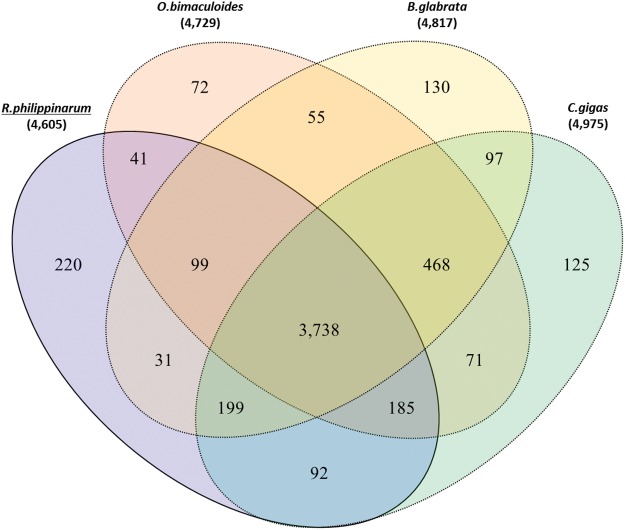
Orthologous gene clusters in the Mollusca lineage. Venn diagram shows the number of unique and shared gene families among the four Mollusca genomes (manila clam, octopus, snail, and oyster).